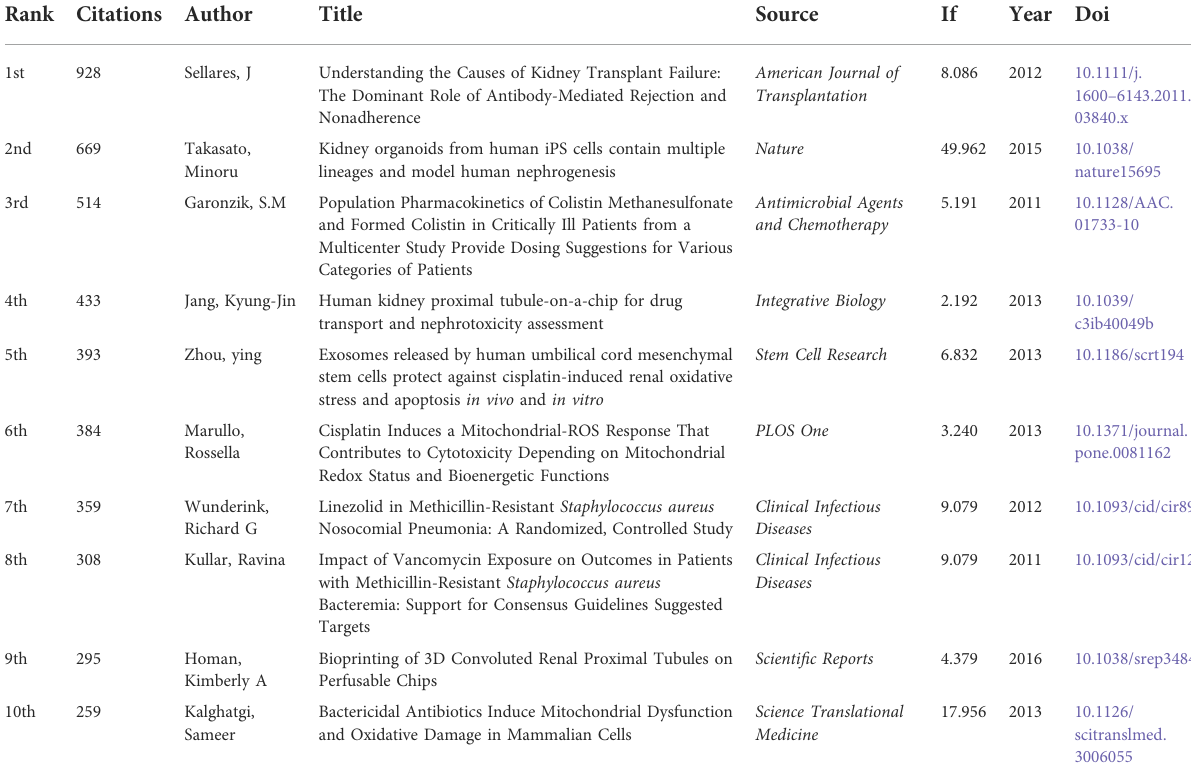
TABLE 3 Top 10 highly cited literature in nephrotoxicity